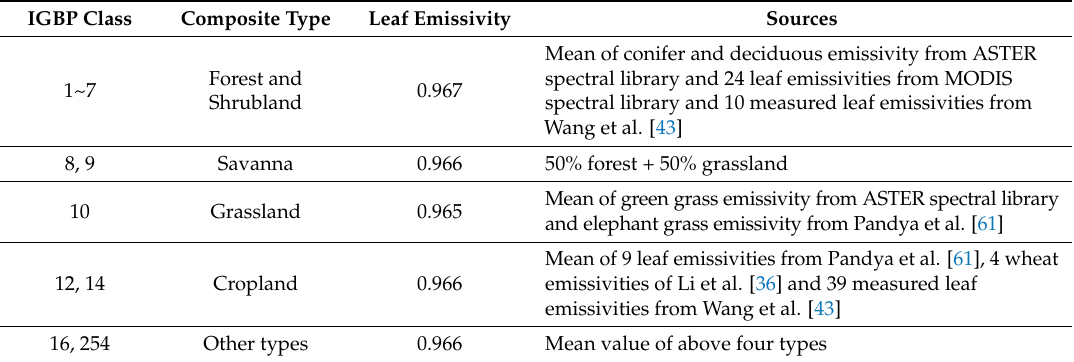
Table 1. Leaf emissivity values for five composited vegetation land cover types.